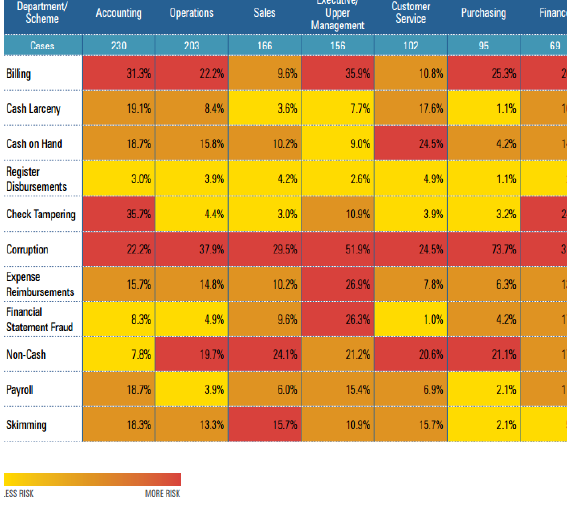
Figure 6. Frequency of Schemes Based